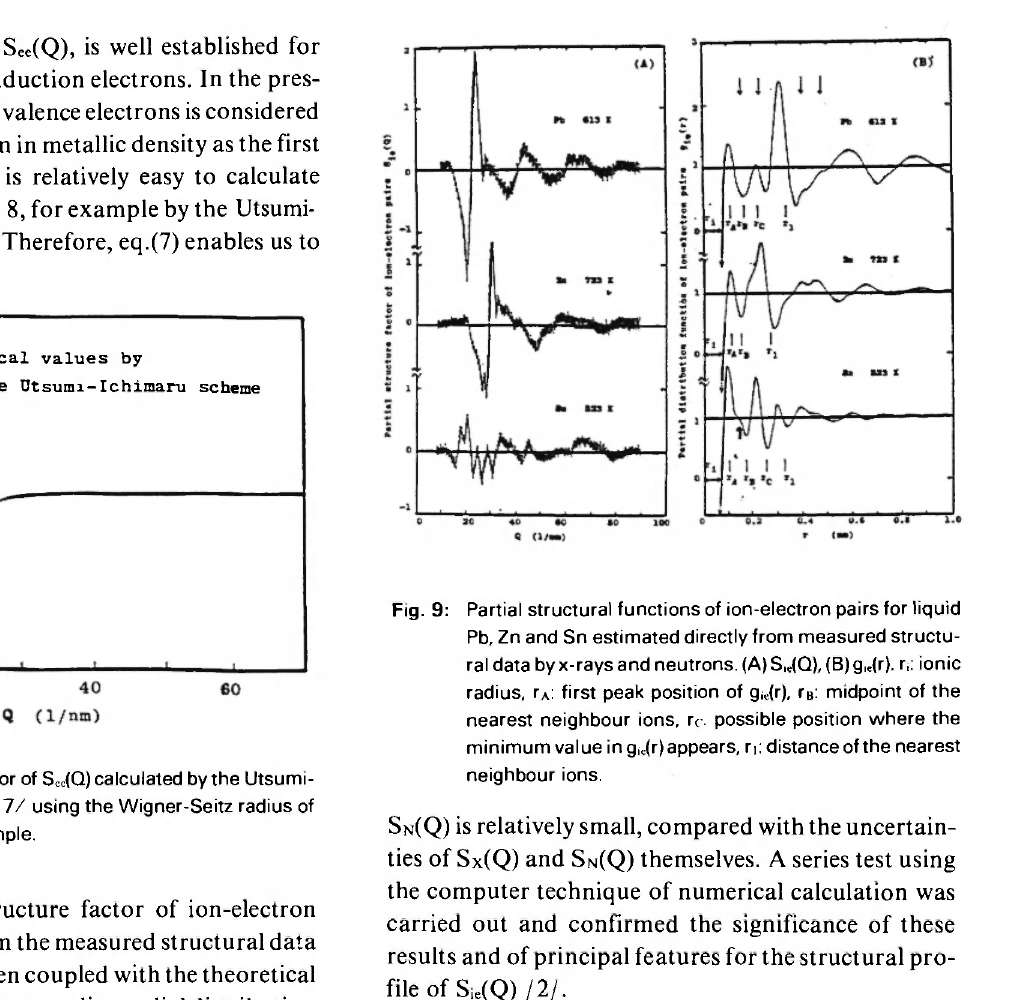
Fig. 9: Partial structural functions of ion-electron pairs for liquid Pb, Zn and Sn estimated directly from measured structu- ral data by x-rays and neutrons. (A) S le (Q). (B) g„(r). r { : ionic radius, r A : first peak position of g ie (r), r B : midpoint of the nearest neighbour ions, re possible position where the minimum value in g ic (r) appears, r ι: distance of the nearest neighbour